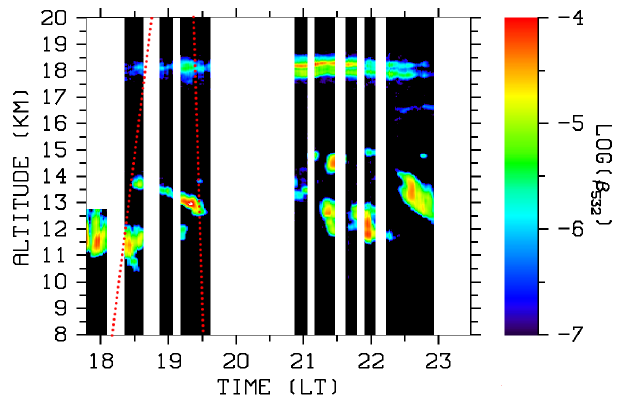
Fig. 13. The same as Fig. 9, but for 14 January 2006. Dotted red lines: ascent and descent of the sounding shown in Fig. 12.